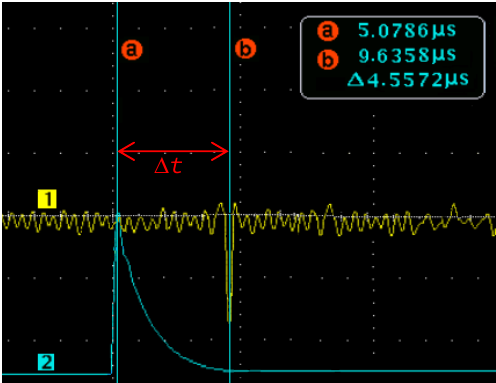
Figure 2. Travel time of surface waves in the base material without stress. The change in distance is ∆ l = 12.82 mm, Channel 1 is the vibration signal, Channel 2 is the time reference signal, a and b are the cursors for reading travel time.